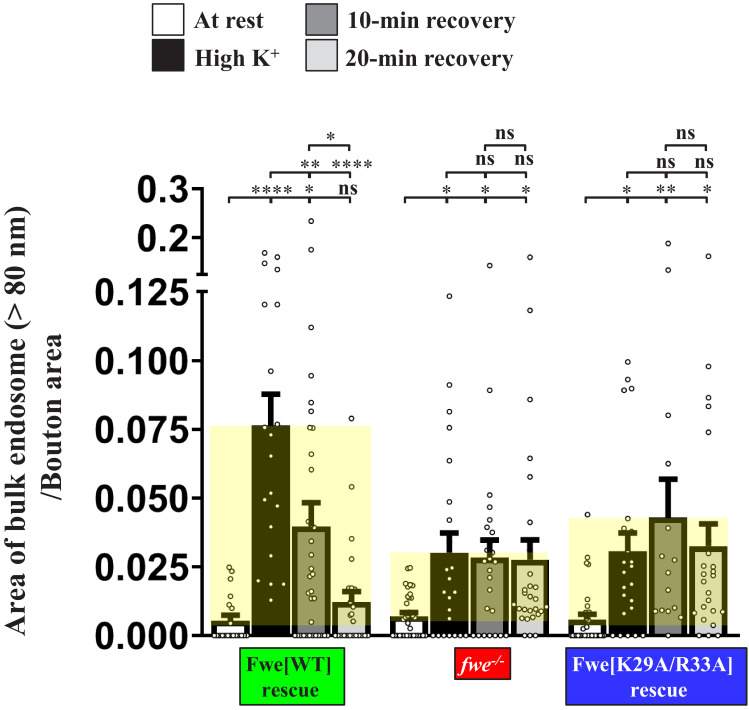
Blockade of the positive feedback loop between Fwe and PI(4,5)P2 abolishes SV reformation from the bulk endosome.Quantification data for the ratio of total area of bulk endosomes to bouton area of the indicated genotypes. Individual data values are shown in the graphs. p values: ns, not significant; *p<0.05; **p<0.001; ****p<0.0001. Mean ± SEM. Statistics: One-way ANOVA with Tukey’s post hoc test.
Figure 5—figure supplement 1—source data 1.Source data for Figure 5—figure supplement 1.